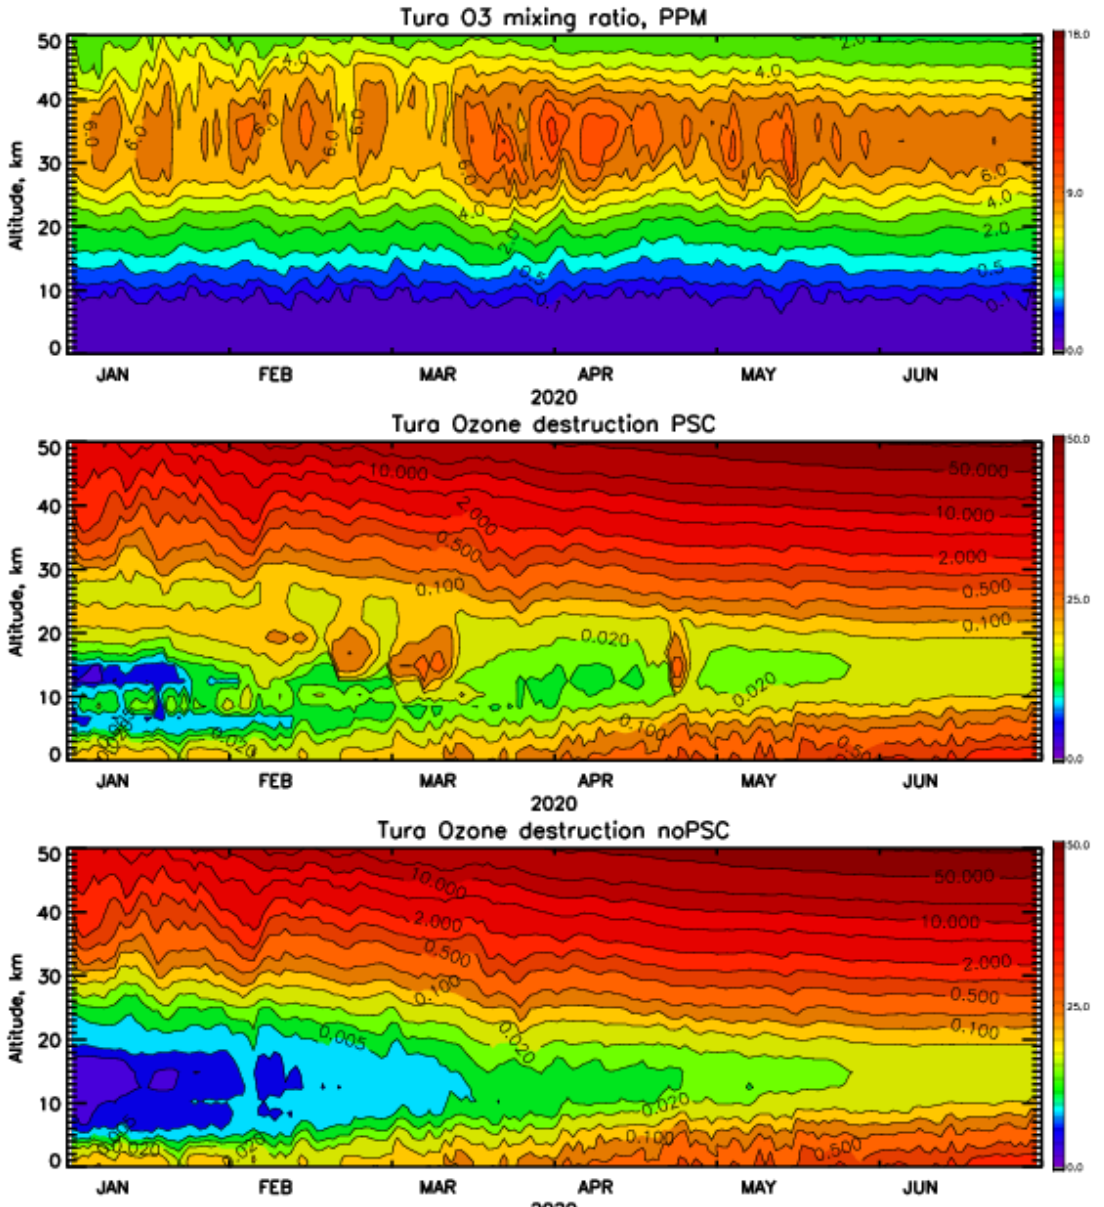
Figure 12. Ozone-mixing ratio at Tura Station for the first half of 2020 ( top ), ozone destruction coefficient for PSC scenario ( middle ) and for noPSC scenario ( bottom ).